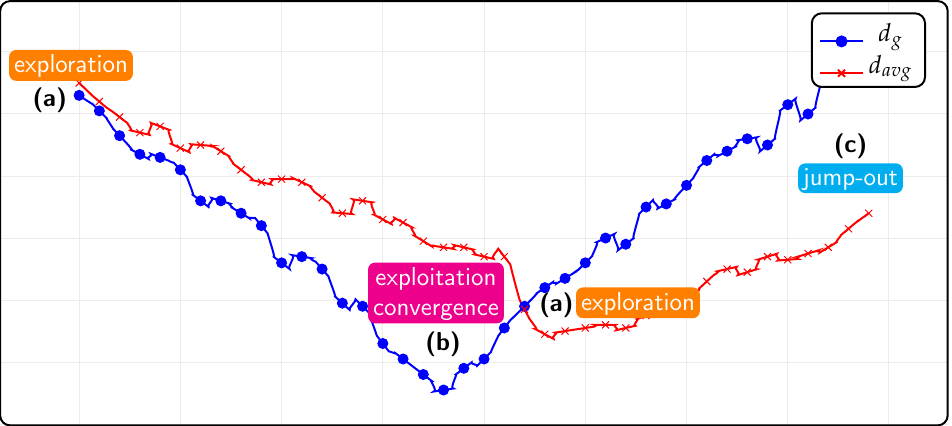
Figure 2. Example of PSO particle distribution: ( a ) d g ≈ d avg exploration; ( b ) d g (cid:28) d avg exploitation, convergence; and ( c ) d g (cid:29) d avg jump